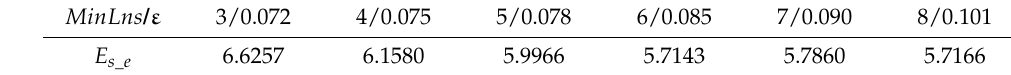
Figure 13. The k Distance curve of integrated distance. Table 2. Clustering evaluation result with different MinLns and ε . Table 2. Clustering evaluation result with different 𝑀𝑖𝑛𝐿𝑛𝑠 and 𝜀 .